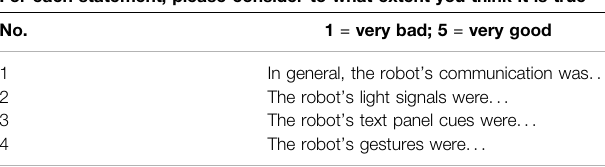
TABLE 3 | The items used for the rating of the communication channels. For each statement, please consider to what extent you think it is true